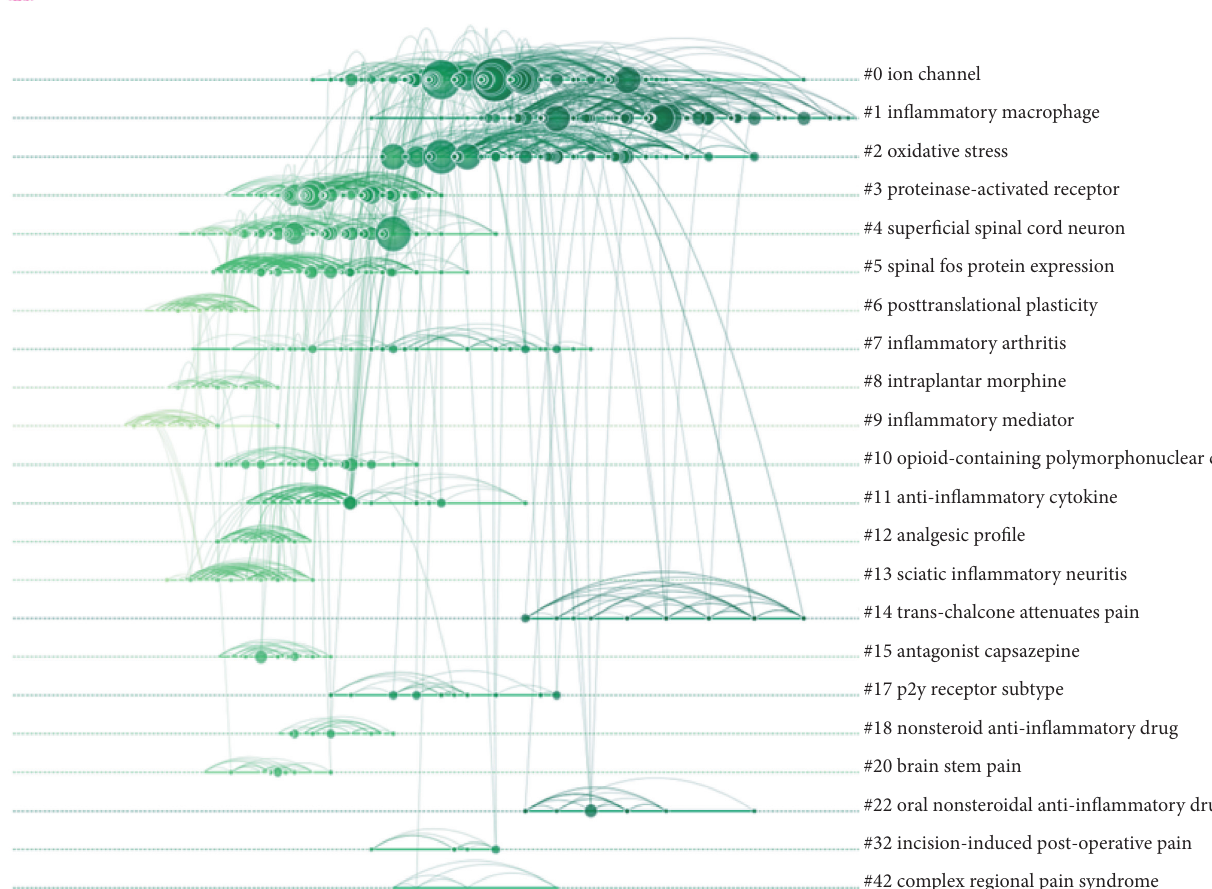
Figure 10: The analysis of references. Cocitation map (timeline view) of references from publications on pain and inflammation research.